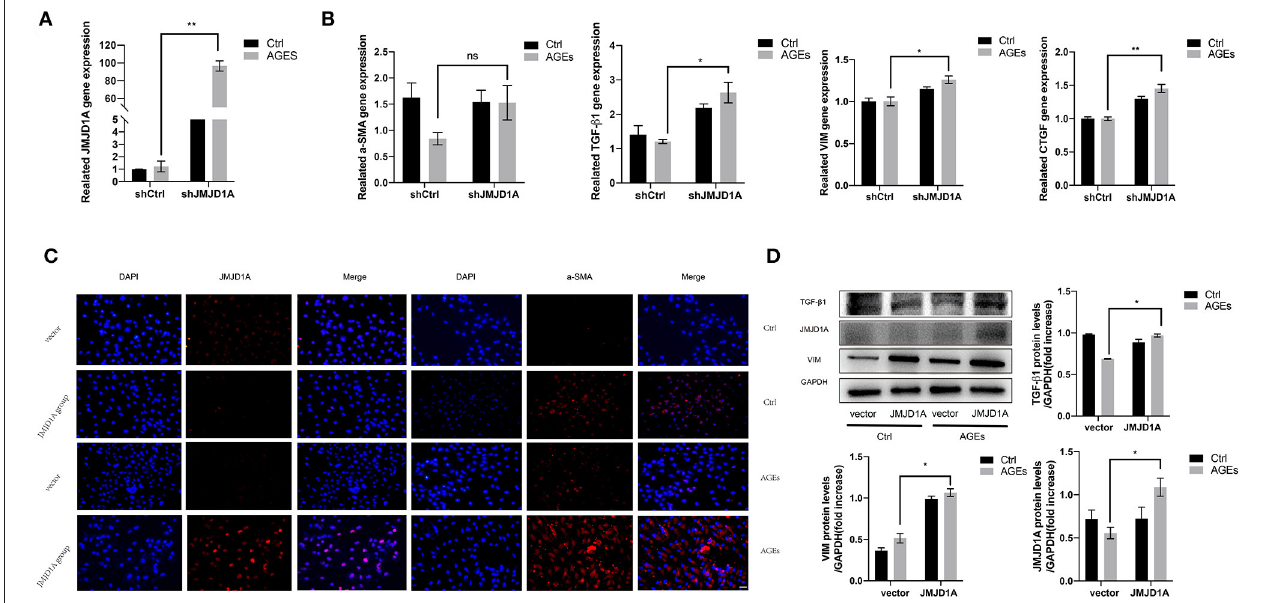
FIGURE 6 | Overexpression of JMJD1A accelerates the expression of fibrosis related factors in AGEs stimulated HK-2 cells. The JMJD1A lentiviral vector was constructed and transfected into HK-2 cells to obtained the HK-2 cell line stably transfected with overexpression of JMJD1A. (A,B) After being cultured with 400 µ g/ml AGEs for 72h, RT-qPCR detection of the mRNA expressions of JMJD1A, a-SMA, TGF- β 1, VIM, and CTGF in the JMJD1A group increased compared with vector group ( n = 3, * p < 0.05, ** p < 0.001). (C) The expression level of a-SMA in the AGEs JMJD1A group detected by immunofluorescence increase compared with AGEs vector group (scale bar, 100 µ m). (D) The protein expression level of TGF- β 1, VIM, and JMJD1A in the AGEs JMJD1A group detected by Western blot increased compared with AGEs vector group ( n = 3, * p <